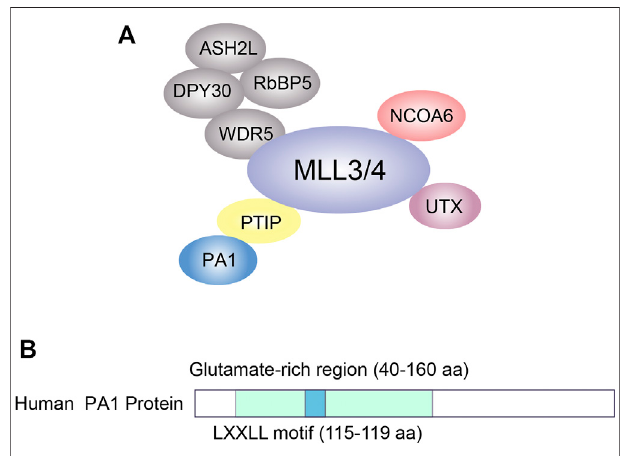
FIGURE 1 | The schematic image of KMT2C/D complex (A) and the protein structure of PA1 protein (B) .